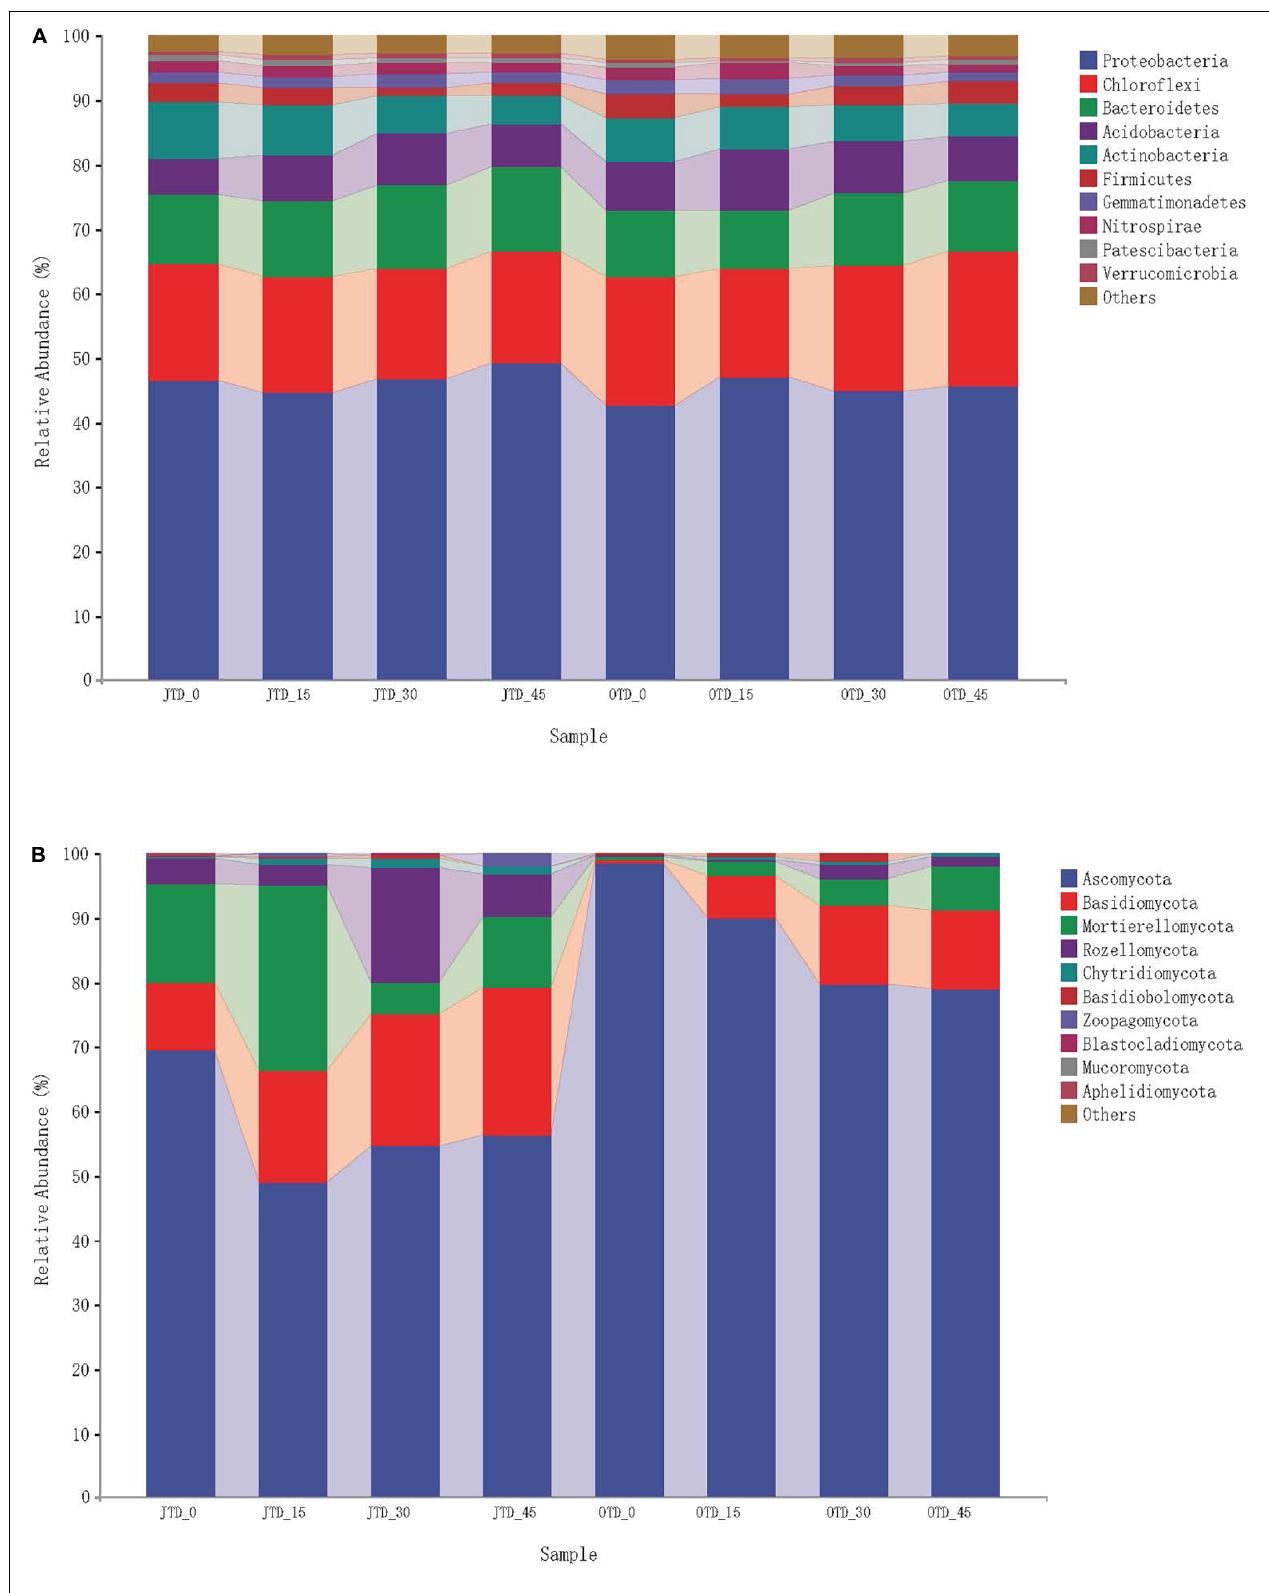
FIGURE 1 | Relative abundance of bacterial group (A) and fugal group (B) under different protein content diets treatments in July and October.